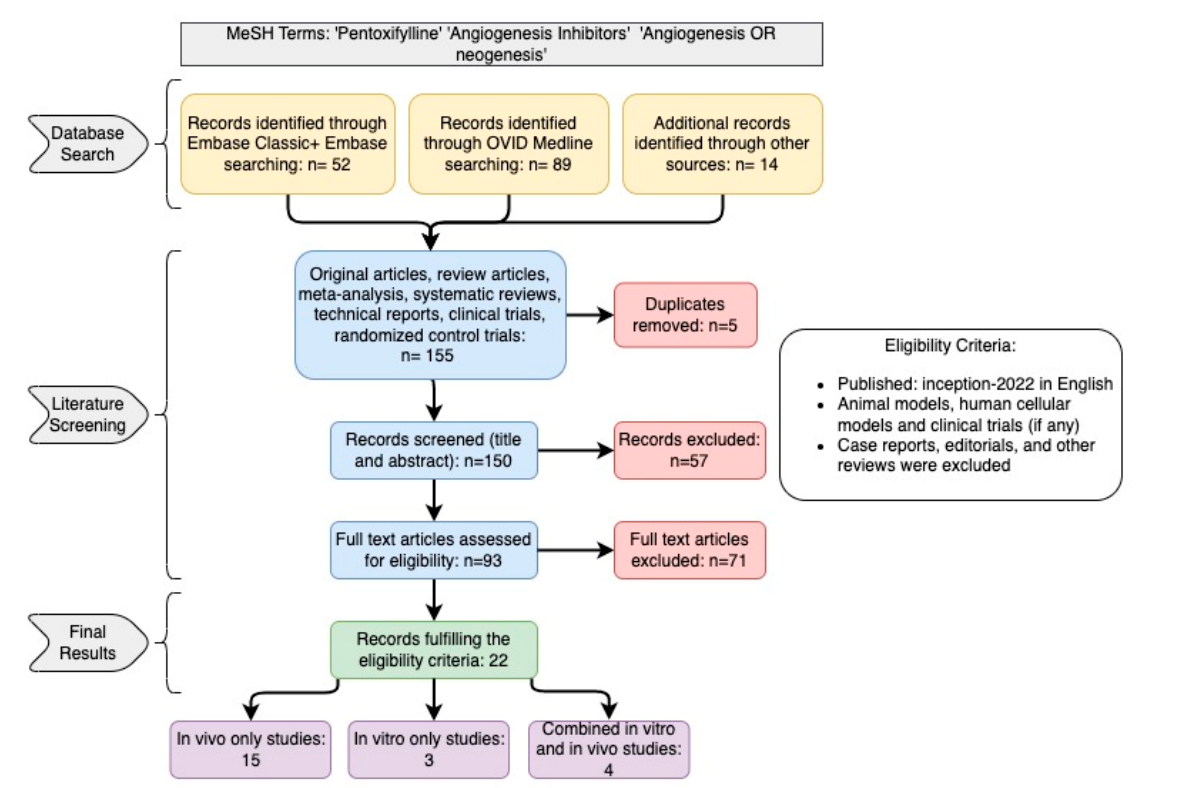
Figure 1. Literature Search and Screening Flowchart. The database search results (yellow) were compiled into a pool of eligible records that would proceed through the literature screen (blue). Duplicates and ineligible records were excluded (red). The remaining records that met the eligibility criteria were included in the review and broken down by study design (purple).